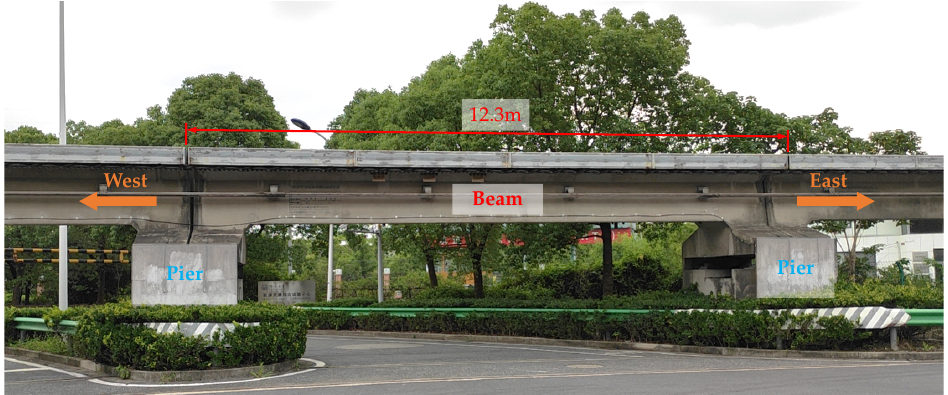
Figure 7. The concrete maglev bridge.